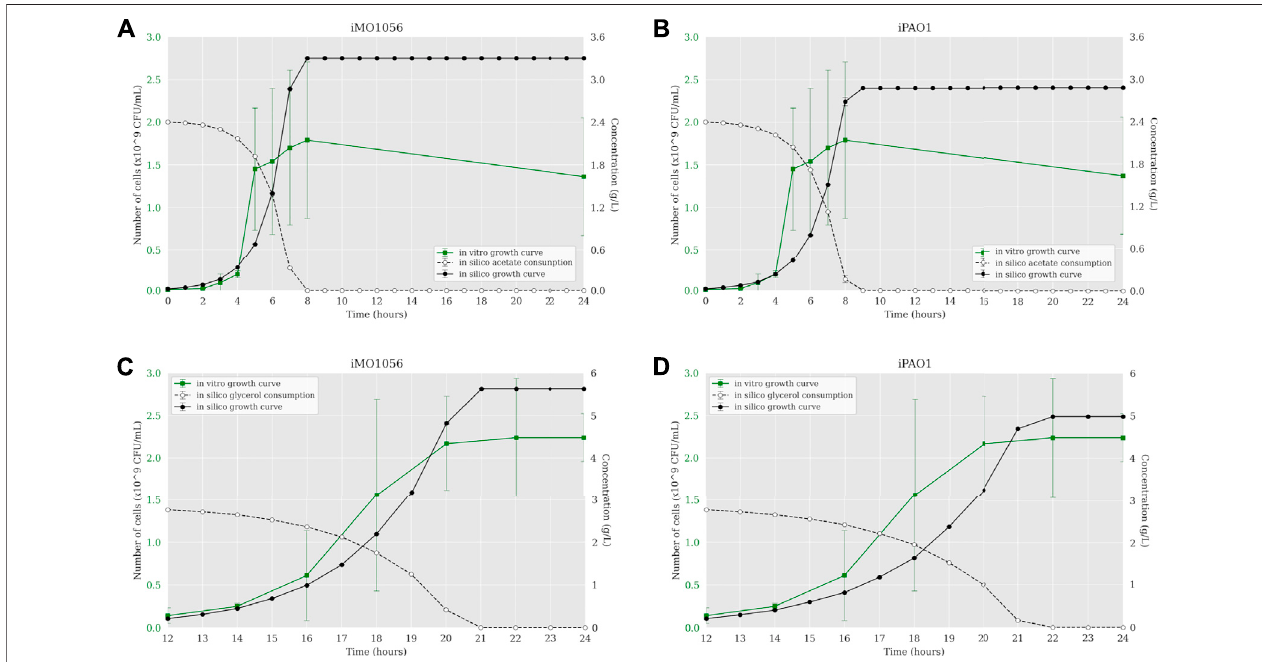
FIGURE 2 | Comparison between P. aeruginosa growth curves predicted by ACBM from the metabolic models with adjusted carbon source uptake rates and growth curves measured by Dolan et al. (2020). (A,B) MOPS minimal medium with acetate as carbon source. (C,D) MOPS minimal medium with glycerol as carbon source. The graphics include the carbon source consumption over time (dashed lines). All measurements were made at least in triplicates, and curves represent the mean of all replicates. Error bars are the standard deviation of the